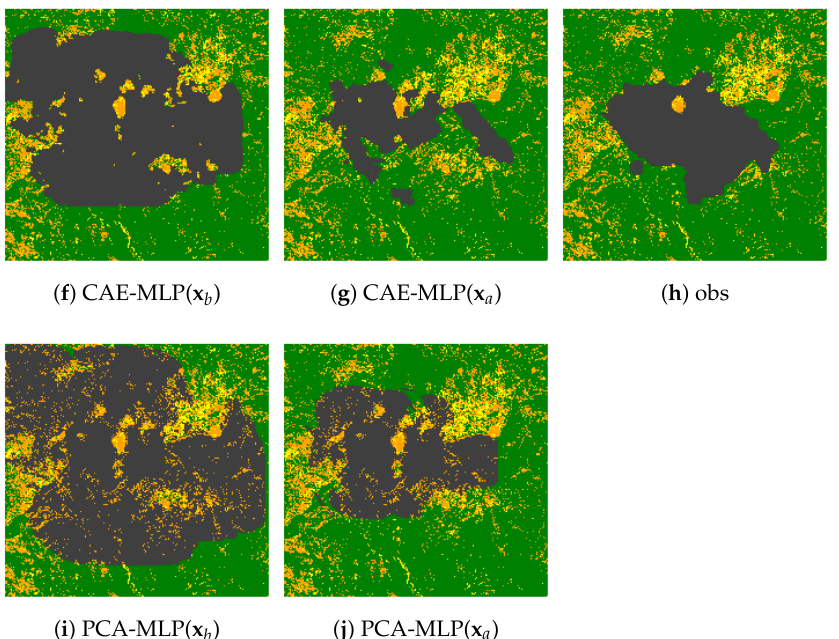
Figure 10. Machine learning (DL) prediction of burned area at day 6 for both fire events using original ( x b ) and assimilated ( x a ) parameters compared to satellite observations. The results of both CAE-MLP ( a , b , f , g ) and PCA-MLP ( d , e , i , j ) are